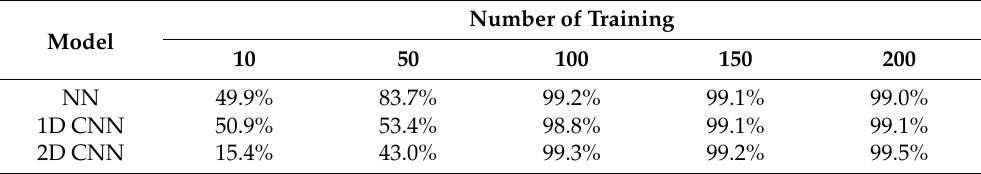
Table 6. Accuracy for NN, 1D CNN, and 2D CNN trained by using packet traffic dataset. Model